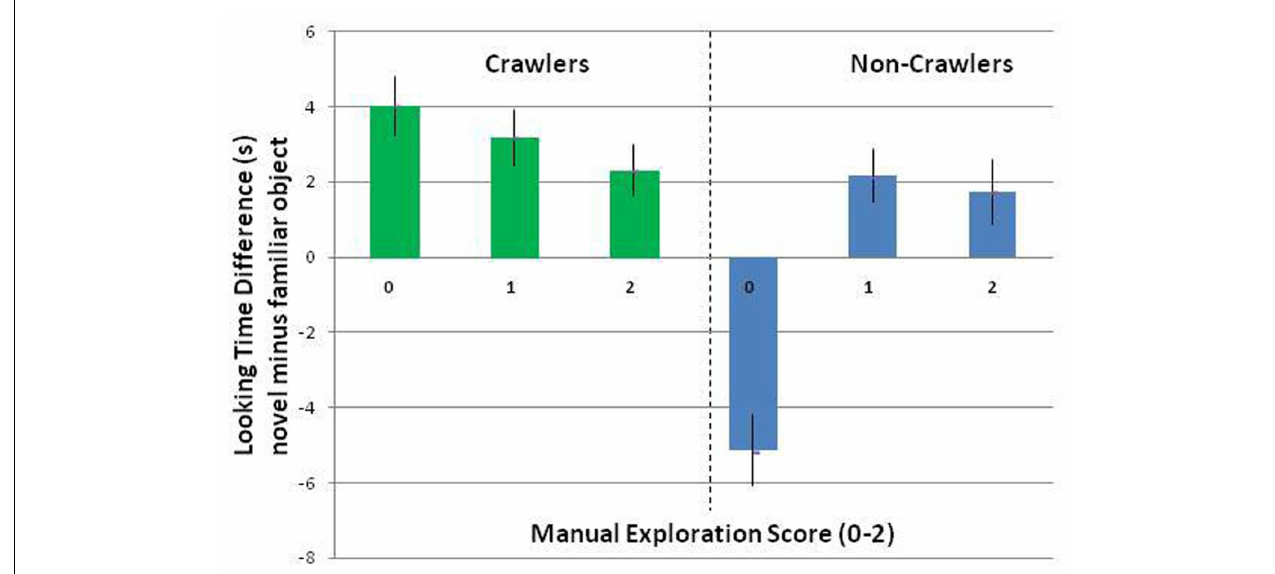
FIGURE 4 | Nine-month-olds’ mean looking time differences between novel (mirror) and familiar test objects. Error bars indicate standard error of the